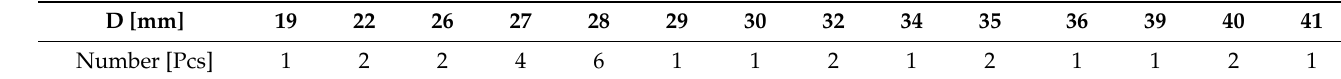
Table 5. Ball characteristic.